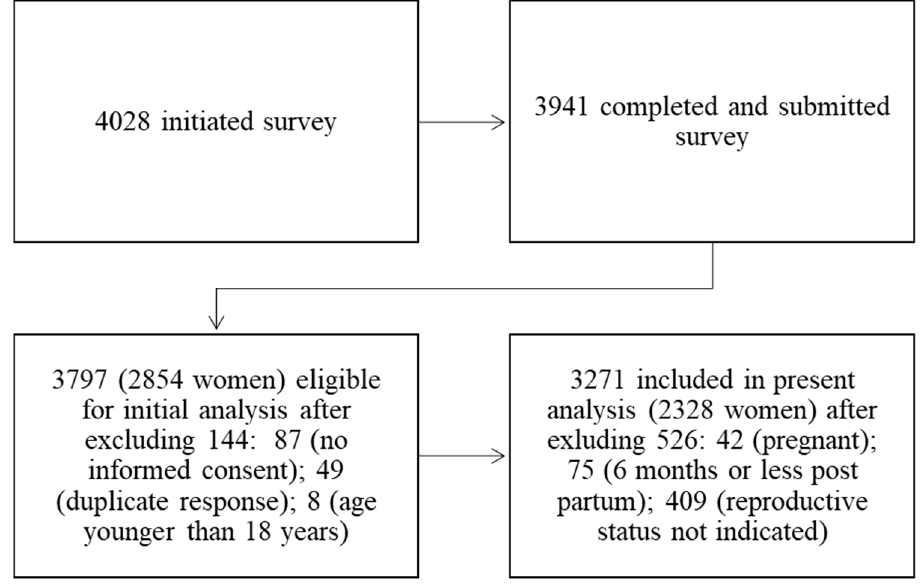
Figure 1. Participant Dispensation.